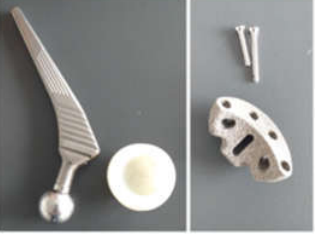
Figure 2. Prosthetic components used for revision prosthesis (prosthesis stem, prosthesis cup, titanium augment, and orthopaedic screws).